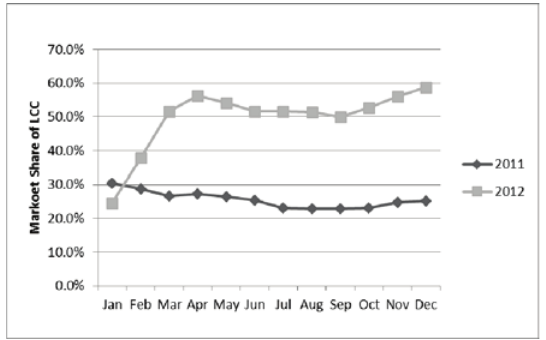
fig. 8. Market share of LCCs by passengers (Source: own edition based on Hungaro Control Data)